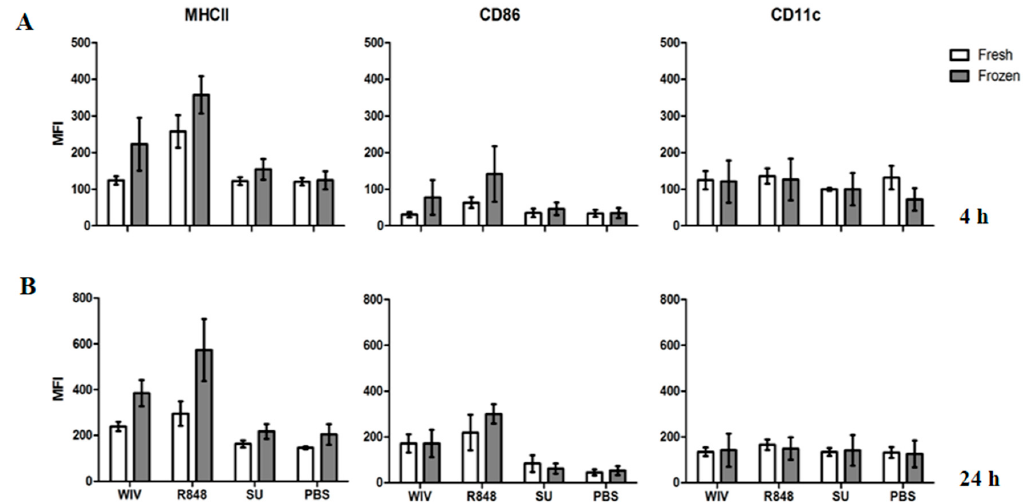
Figure 5. Mo-DCs obtained from freshly isolated and frozen/thawed peripheral blood mononuclear cells (PBMCs) are equally able to upregulate expression of surface markers upon stimulation with WIV or R848. Monocyte-derived DCs from freshly isolated and frozen/thawed PBMCs of matching donors were differentiated for 6 days and stimulated with WIV, R848, SU and PBS for 4 h ( A ) and 24 h ( B ). Bars represent the MFI for MHCII, CD86 and CD11c of four different donors +/ − standard deviation.